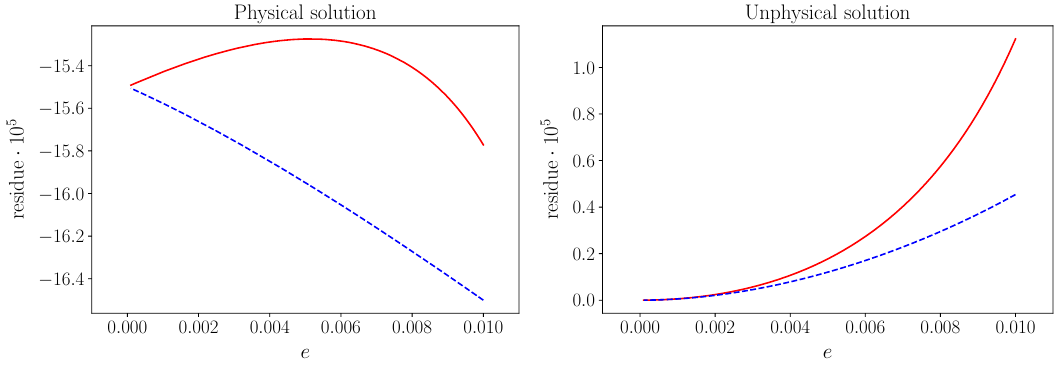
Figure 9 . The e -dependence of the residua for the physical and unphysical levels. The blue and red curves correspond to the two different solutions of the quantization